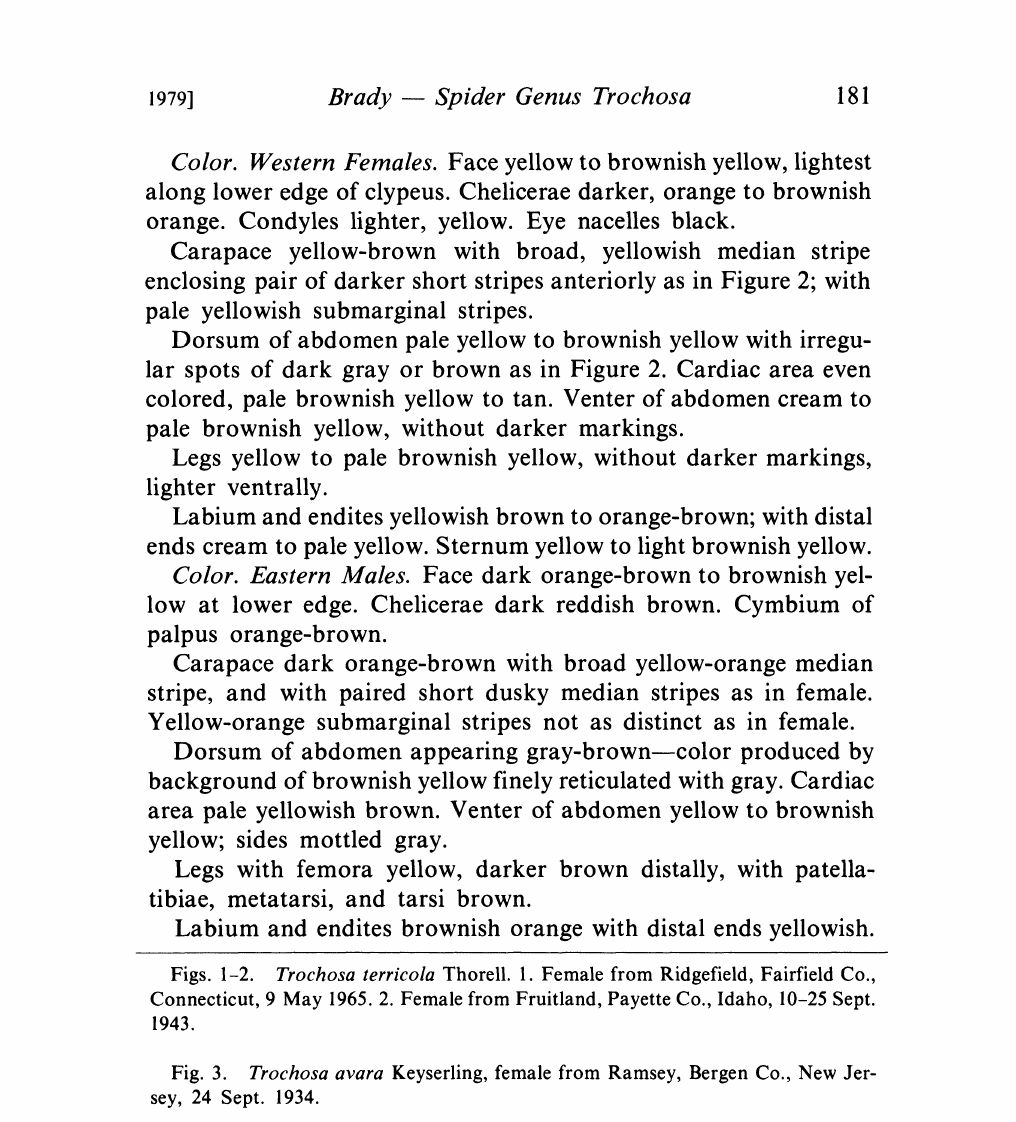
Figs. 1-2. Trochosa terricola Thorell. 1. Female from Ridgefield, Fairfield Co., Connecticut, 9 May 1965.2. Female from Fruitland, Payette Co., Idaho, 10-25 Sept. 1943. Fig. 3. Trochosa avara Keyserling, female from Ramsey, Bergen Co., New Jer- sey, 24 Sept. 1934. Fig. 4. Trochosa gosiuta (Chamberlin), female from Timpanogos Park, Ameri- can Fork Canyon, Salt Lake Co., Utah, 13 June 1941. Fig. 5. Trochosa shenandoa Chamberlin and Ivie, female holotype from Shenan- doah National Park, Virginia, 5 July 1933. Fig. 6. Trochosa parthenus (Chamberlin), female from Alachua Co., Florida, 8 Feb.